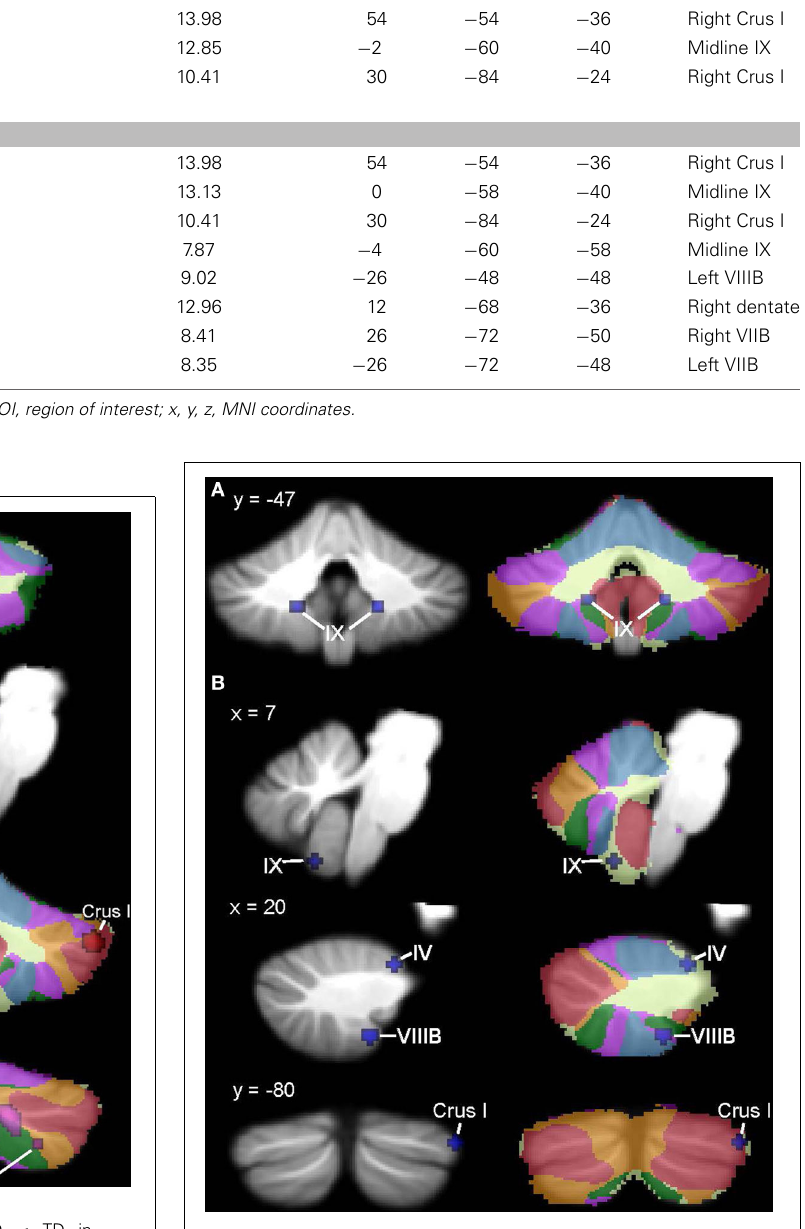
FIGURE 4 | ADHD < TD GM: whole-brain and ROI analyses. Left (A) , Regions in the whole-brain analysis showing significant ALE voxels where ADHD < TD (blue), thresholded at p < 0 . 001, k > 50. (B) Regions showing ADHD < TD in the ROI analysis. Right, corresponding slices showing functional connectivity maps of the cerebellum (Buckner et al., 2011). Networks are color-coded such that blue, somatomotor; green, dorsal attention; violet, ventral attention; cream, limbic; orange, frontoparietal; red, default